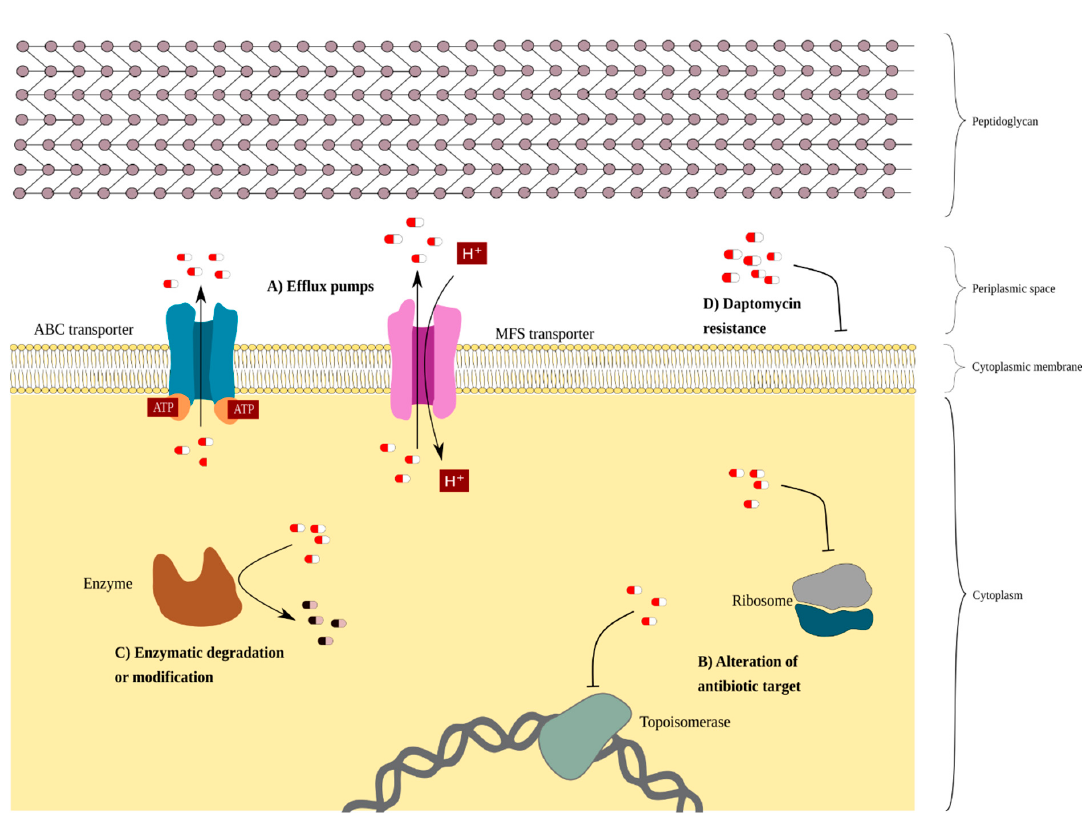
Figure 1. A schematic representation of the drug-resistance mechanism of C. striatum . Antibiotics are represented as pill shapes in white and red. ( A ) The efflux pumps transport phenicols, tetracyclines, and beta-lactams out of the membrane cell. The blue complex protein represents an ABC transporter encoded by the tetA/B genes responsible for transporting tetracyclines and beta-lactams. The pink complex protein represents a specific MFS transporter for chloramphenicol. ( B ) Altering the target of the antibiotic is a form of resistance. Alteration of drug target due to mutations in gyrA prevent the binding of fluoroquinolones to topoisomerases. Resistance to macrolides is due to the modification of the target through the methylation of the 23S subunit of the ribosome, caused by the erm gene. Similarly, the tet(W) gene encoding a ribosomal protective protein, TET(W), confers resistance to tetracyclines. ( C ) Resistance to aminoglycosides is given by the enzymatic modification (phosphorylation or adenylation) of these antibiotics, preventing the binding to the ribosome. Beta-lactam resistance is due to B-lactamases encoded by the bla and ampC genes, which degrade beta-lactam antibiotics. ( D ) Daptomycin resistance is due to the mutation in the pgsA2 gene causing a phosphoglycerol (PG) deficiency in the membrane; this PG deficiency prevents the binding of daptomycin to the membrane.